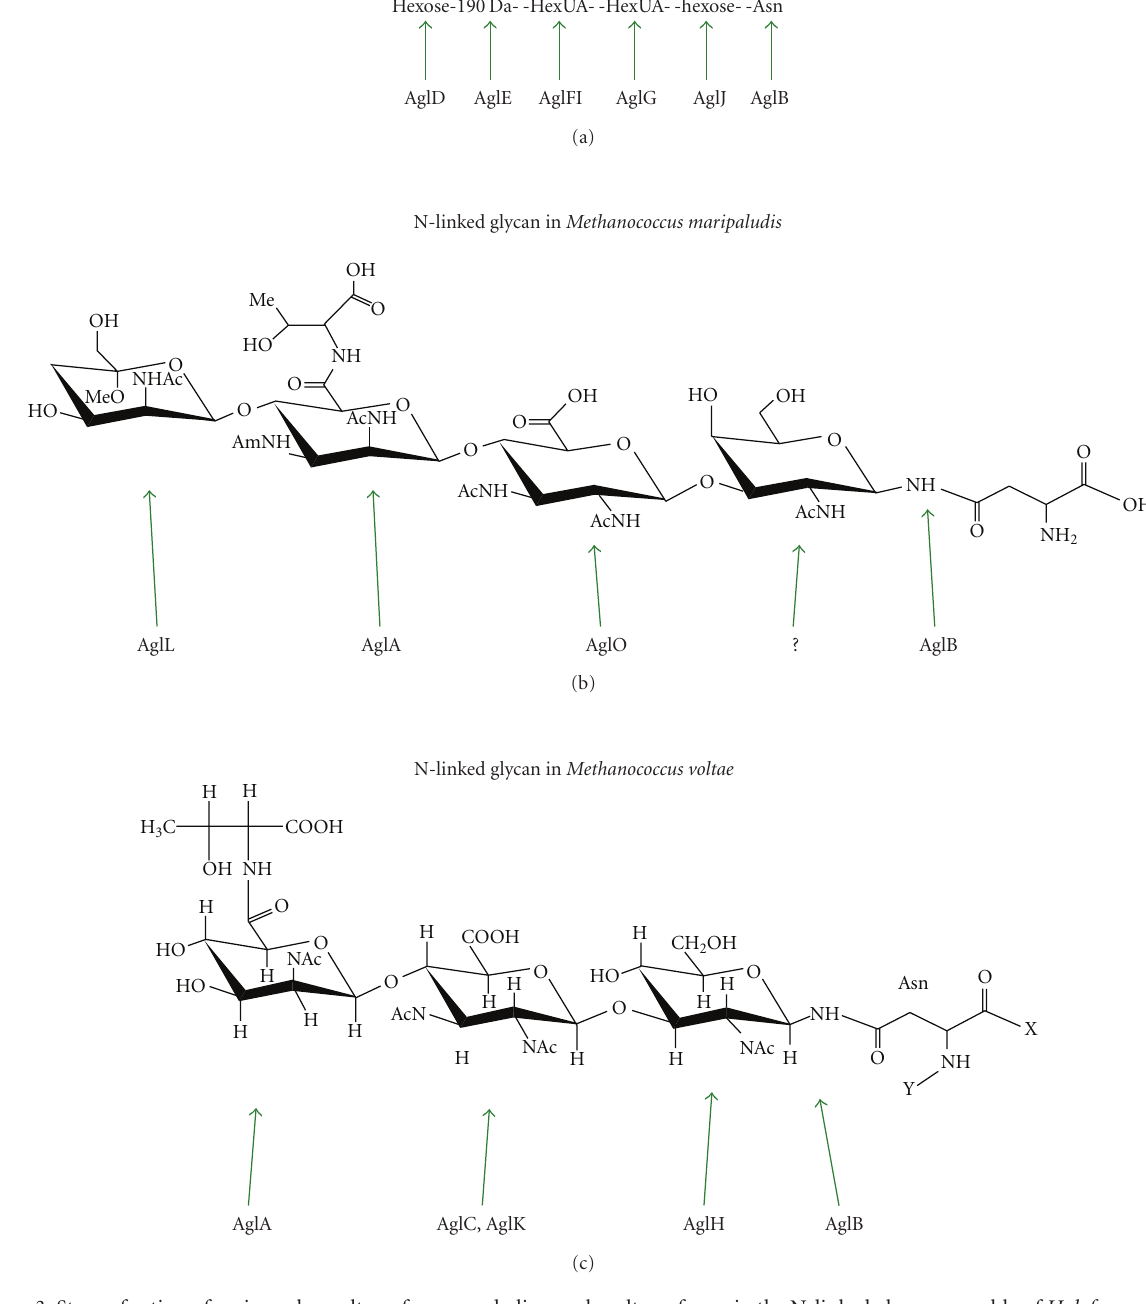
Figure 3: Stage of action of various glycosyltransferases and oligosaccharyltransferase in the N-linked glycan assembly of Haloferax volcanii , Methanococcus maripaludis, and Methanococcus voltae